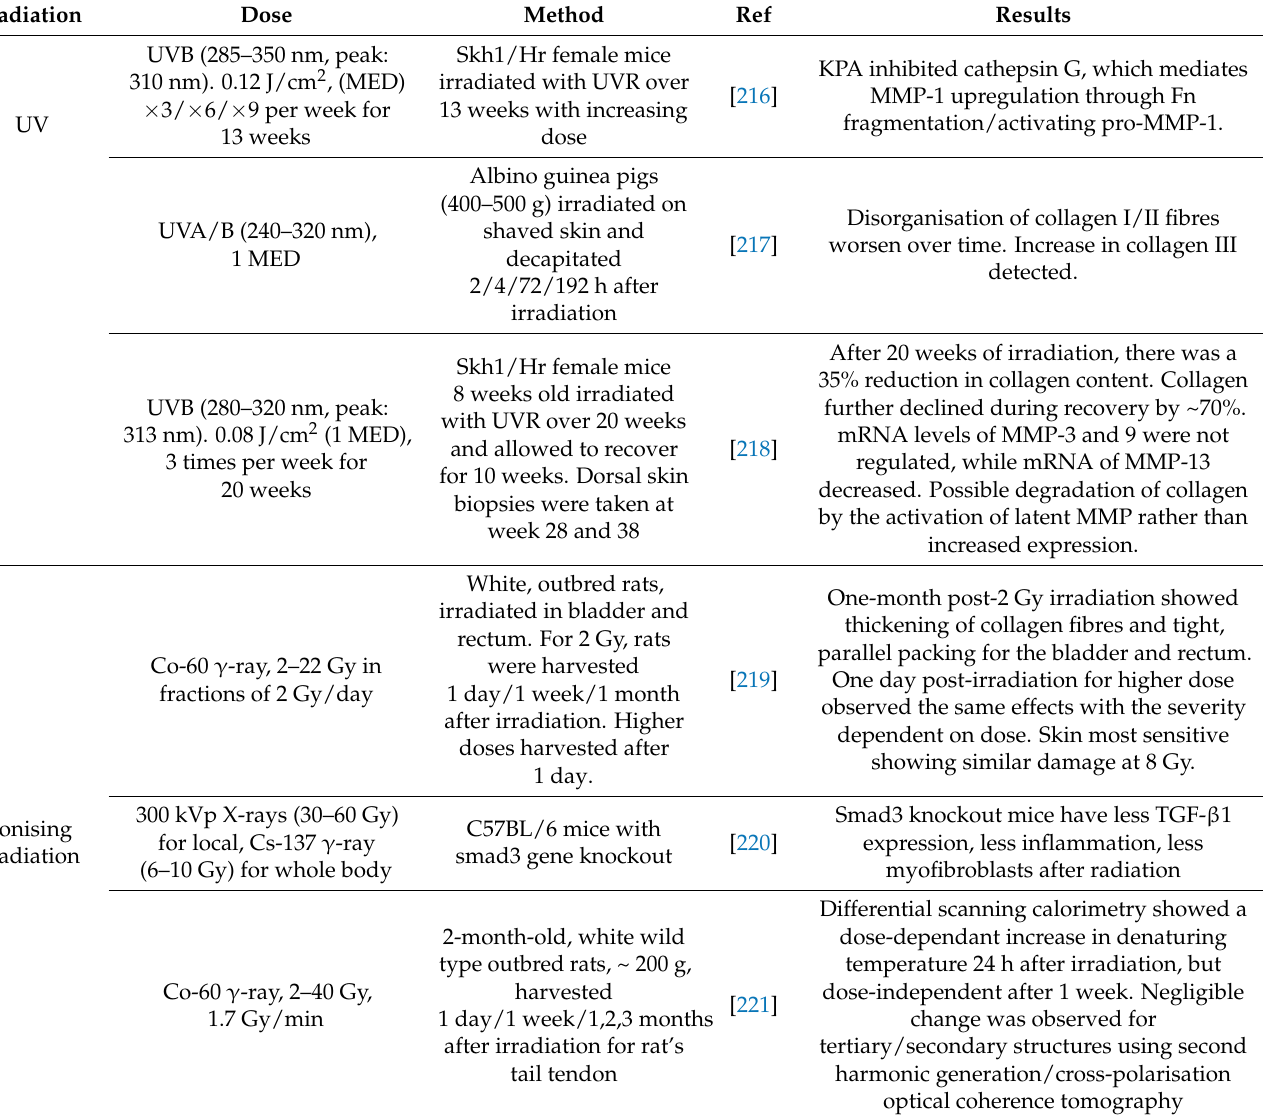
Table 5. In vivo models allow for observations of long-term radiation responses not only in the targeted area but also surrounding tissues or organs for bystander studies. In vivo studies showed that both UVR and ionising radiation-exposed animals experience ECM remodelling as a consequence of protease